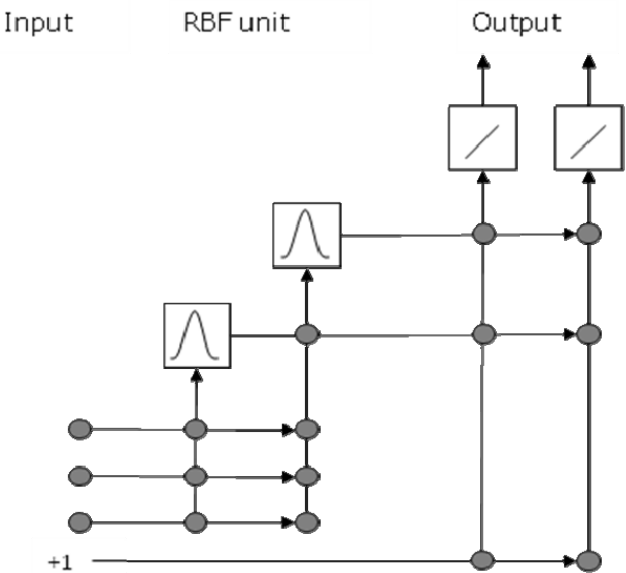
Figure 2. Network architecture of a RBFCCN. This network has three input neurons, two hidden neurons, and two output